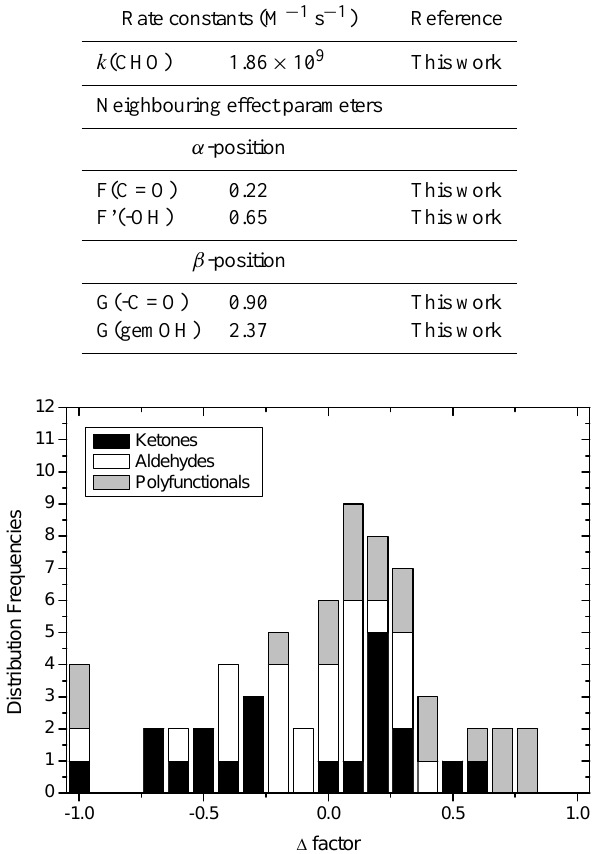
Fig. 2. Statistic distribution of the 1 factor defined as ( k exp – k calc )/ k exp for the present Figure 2. : Statistic distribution of the  factor defined as (k exp -k calc )/k exp for the present SAR. 3